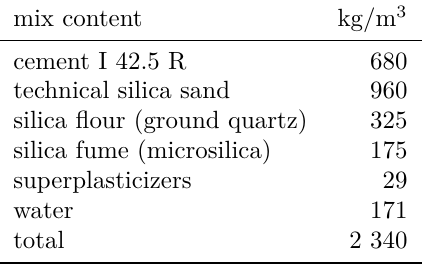
Table 1. HPC mix